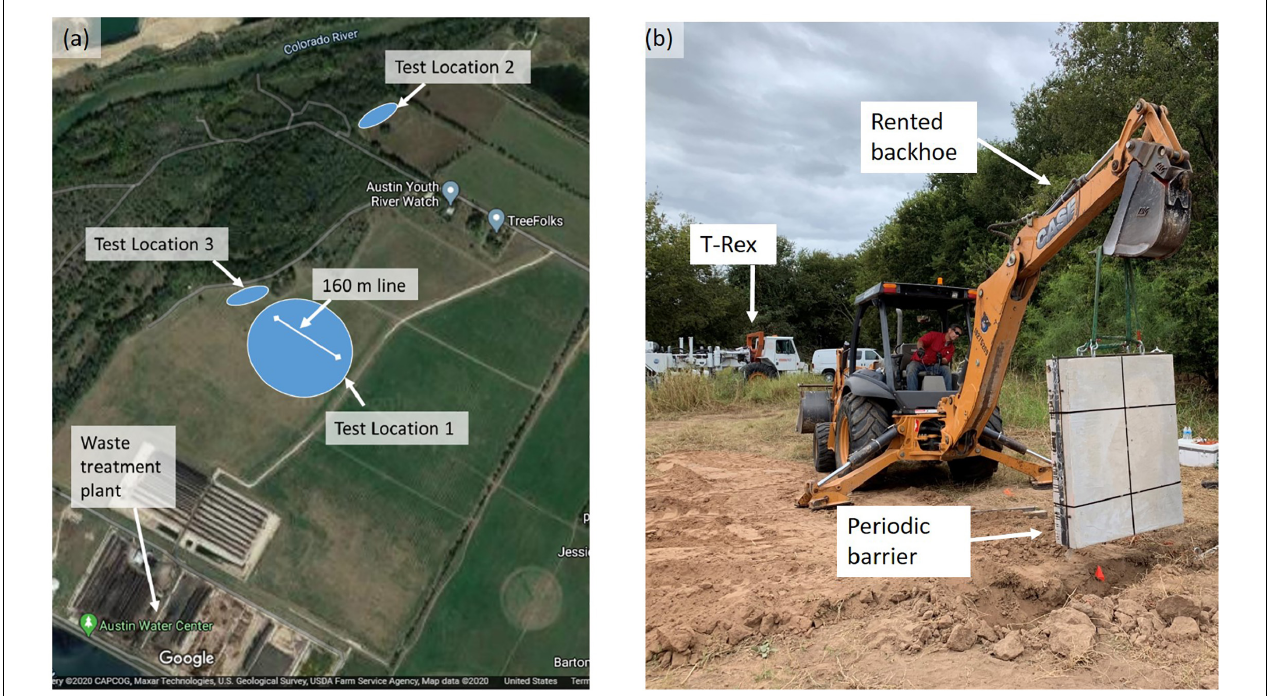
FIGURE 5 | A photograph and a satellite image of the Hornsby Bend (HB) site: (a) Satellite image of the HB site (located about 3.5 km from the Austin-Bergstrom International Airport) and (b) A photograph taken during installation of a periodic barrier at TL2 (from Google